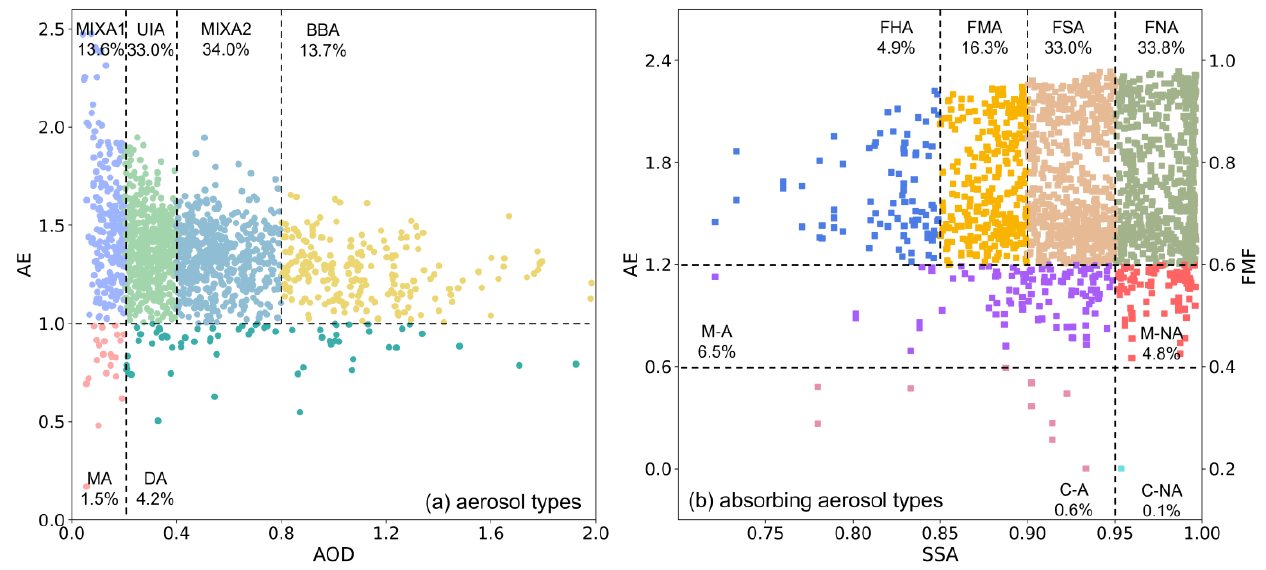
Figure 4. Two aerosol type classification schemes based on the daily measurements of PolyU AERONET station. ( a ) Aerosol types (MIXA: mixed aerosol; BBA: biomass-burning aerosol; MA: marine aerosol; DA: dust aerosol; UIA: urban/industrial aerosol); ( b ) absorbing aerosol types (C-A: coarse absorbing; C-NA: coarse non-absorbing; M-A: mixed absorbing; M-NA: mixed non-absorbing; FSA: fine slightly absorbing; FMA: fine medium absorbing; FHA: fine highly absorbing; FNA: fine non-absorbing).